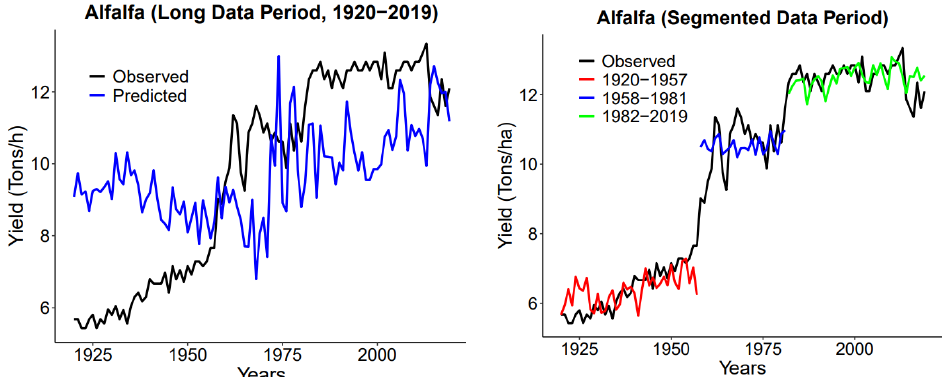
Figure 6. The comparison of observed corn, sorghum, wheat, and alfalfa yields with their respective predicted yields resulting from the best models using 100 years and segmented data period scales.